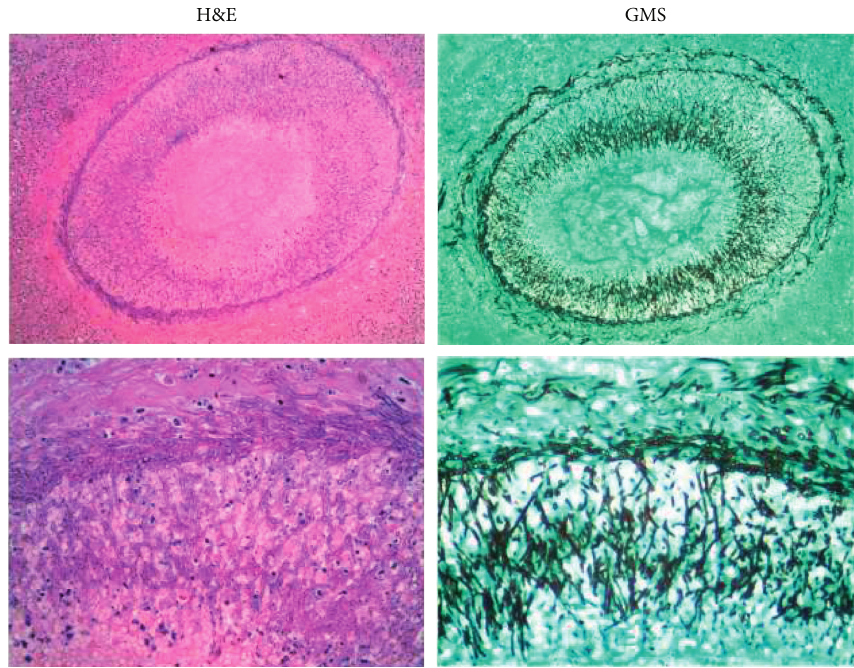
Figure 4: Active invading mycetoma is present in the occipital lobe, with 45-degree branching hyphae spreading horizontally at the peripheral and perpendicularly to the center.